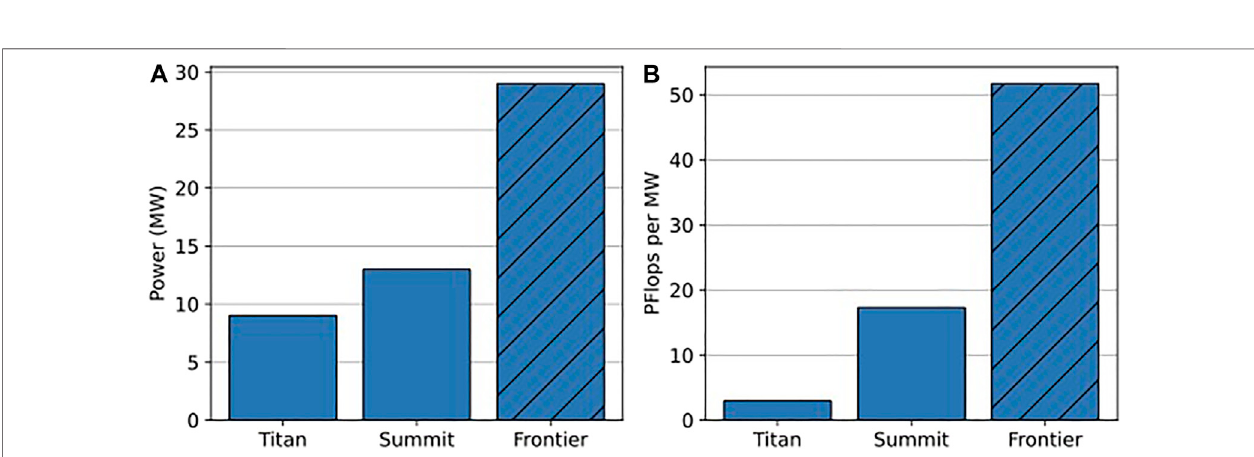
FIGURE 3 | Power consumption (A) and Flops per MW (B) for GPU-accelerated systems deployed at the Oak Ridge Leadership Computing Facility (OLCF). The power requirements for Frontier are projected.